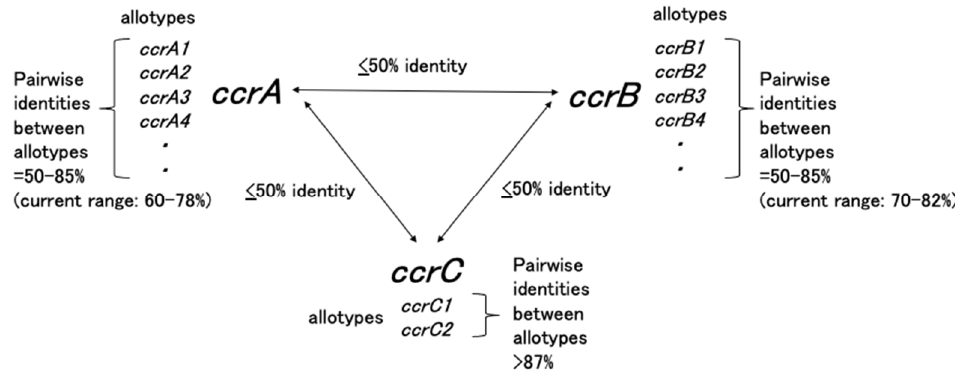
Figure 3. Representation of the naming conventions for ccr genes in S. aureus. Adapted with permission from Ref. [17]. 2009, American Society for Microbiology.